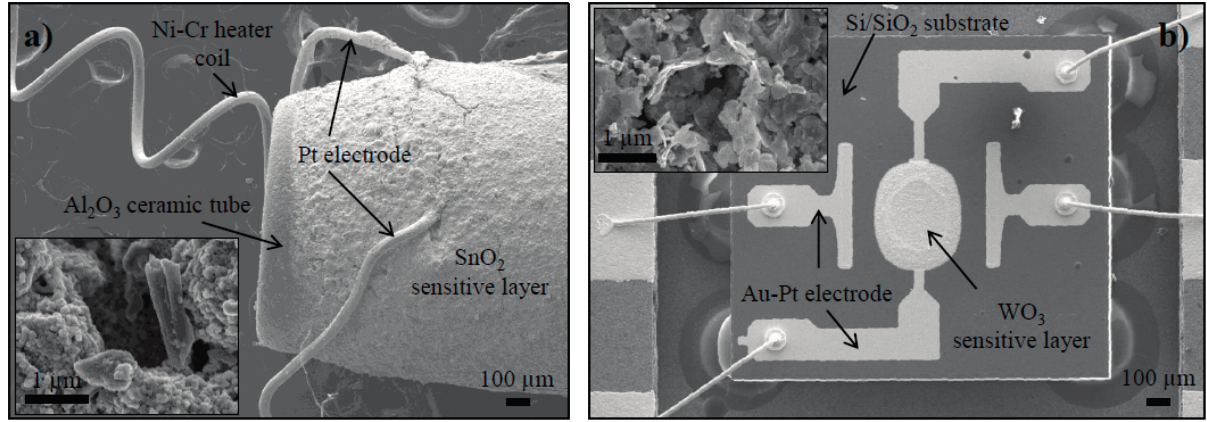
Figure 2. SEM micrograph of the functional parts in ( a ) MQ-3 and ( b ) MiCS-5914 sensor (insets: sensitive MOx layer at higher